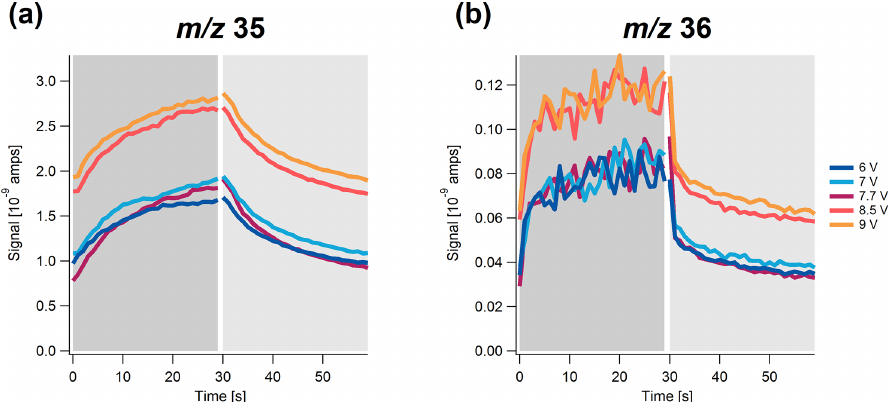
Figure 4. Highly time-resolved signal of (a) m/z 35 and (b) m/z 36 as a function of time at different vaporizer voltages (i.e., temperatures) over a simulated sample (dark gray) and filter (light gray) cycle for NH 4